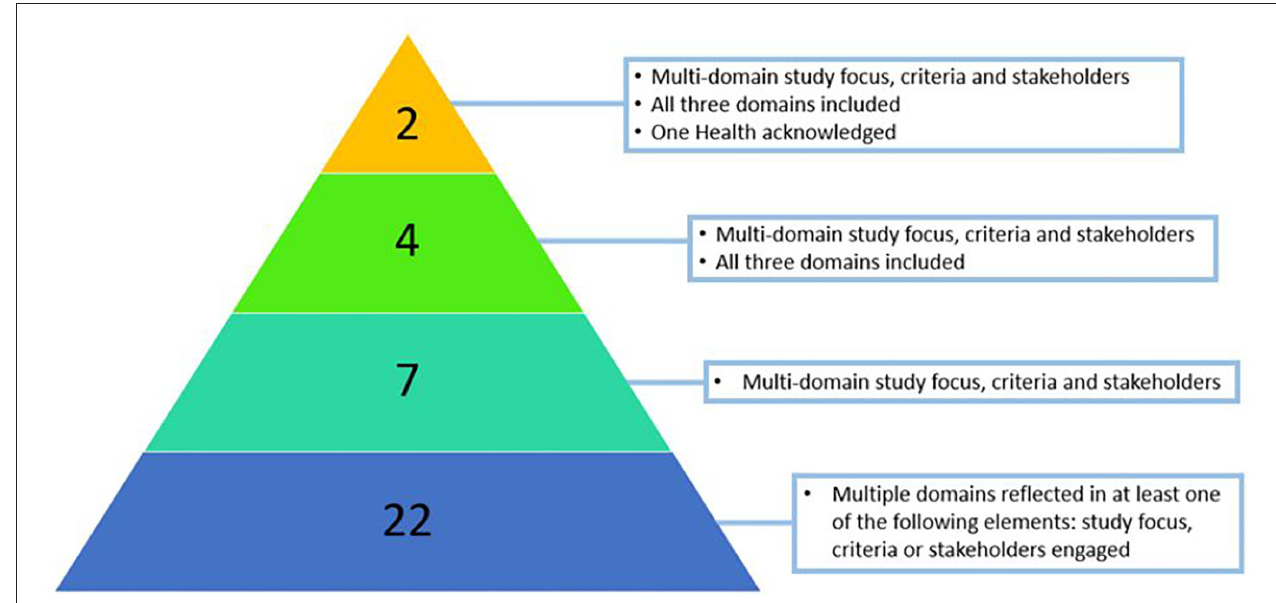
FIGURE 5 | Number of studies at each level of the One Health